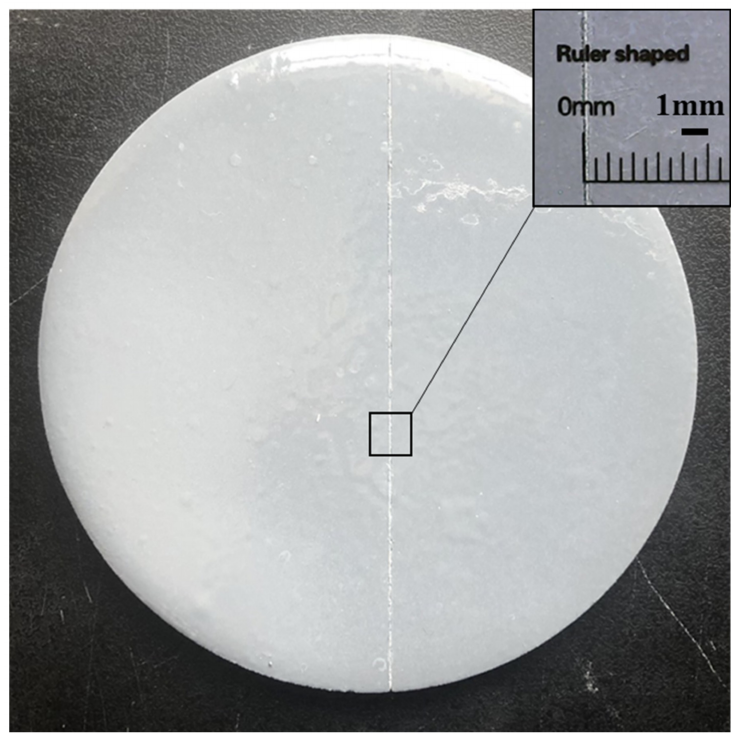
Figure 8. Damage samples of the artificially-generated